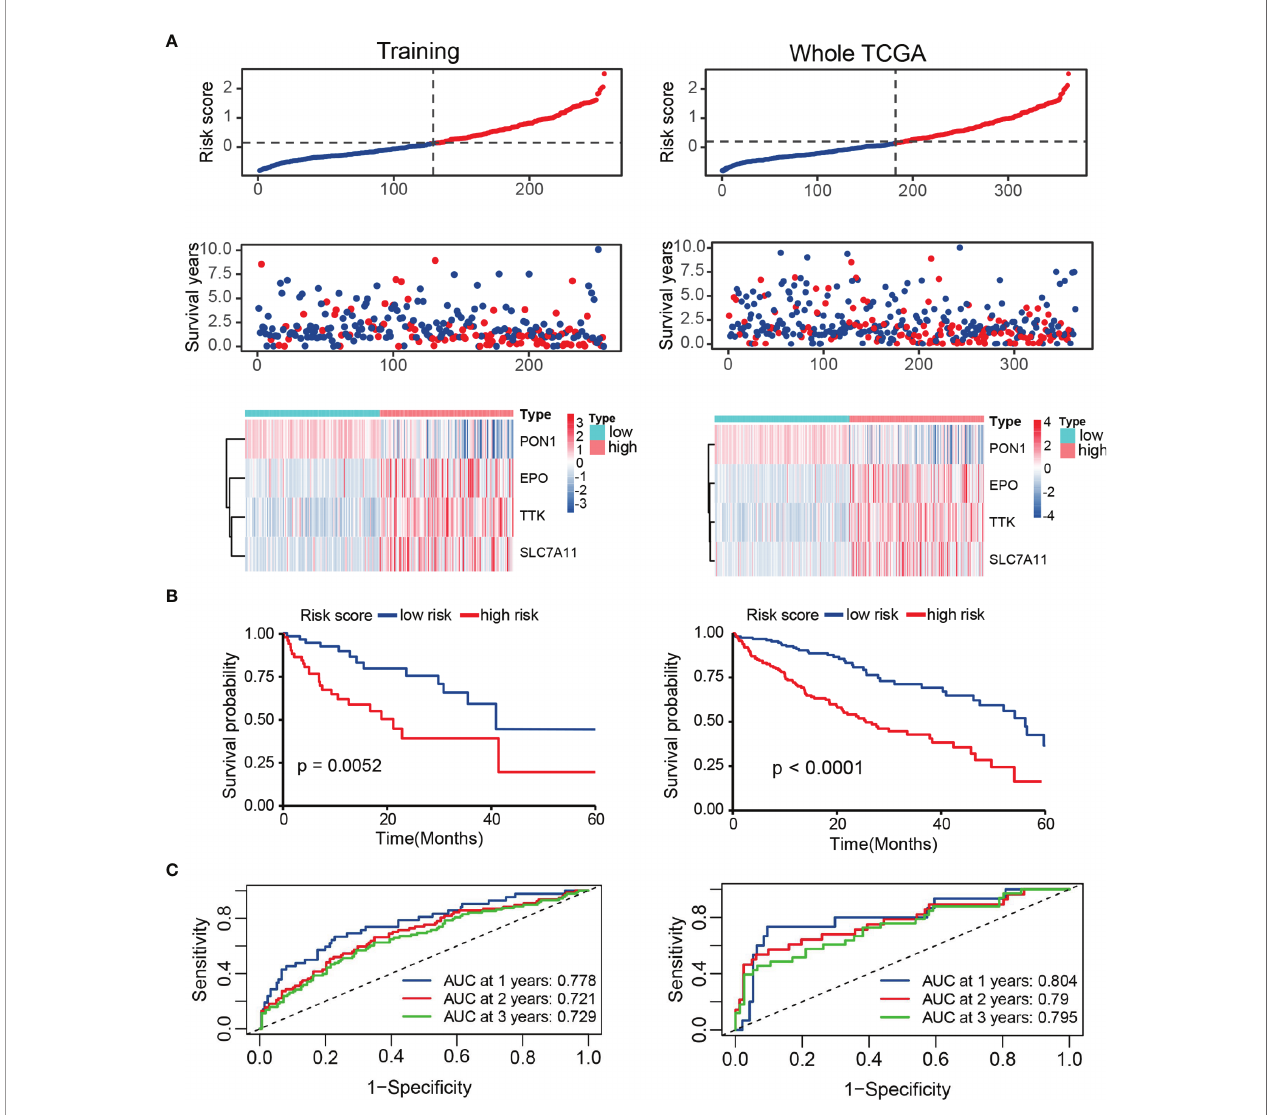
FIGURE 5 | Survival evaluation of TRP score in TCGA. (A) Patients ranked by risk score, corresponding survival status and heatmap of the training set and the whole set. (B) Kaplan – Meier survival curve of OS in the training set and the whole set. (C) ROC curves at 1, 3, and 5 years in the training set and the whole